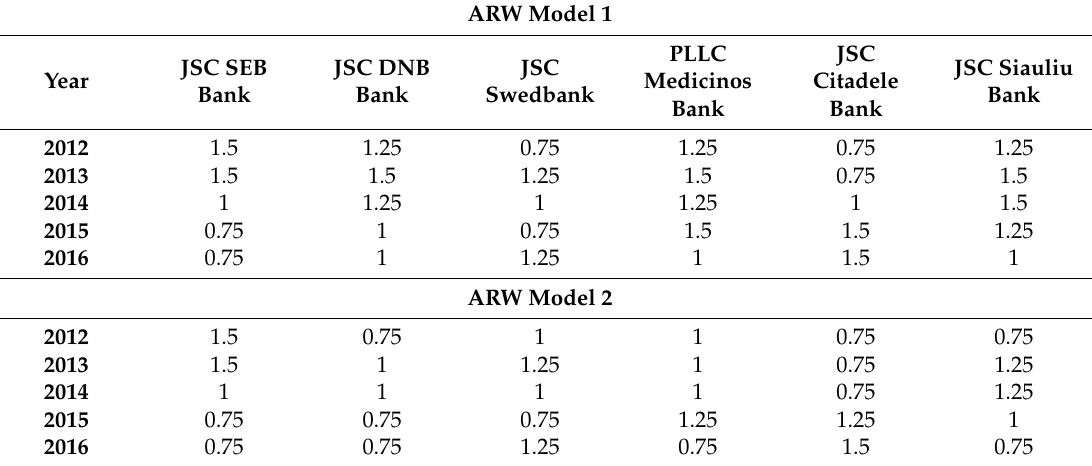
Table 6. The aggregate risk weight (ARW) excluding systemic risk (Model 1) and including systemic risk (Model